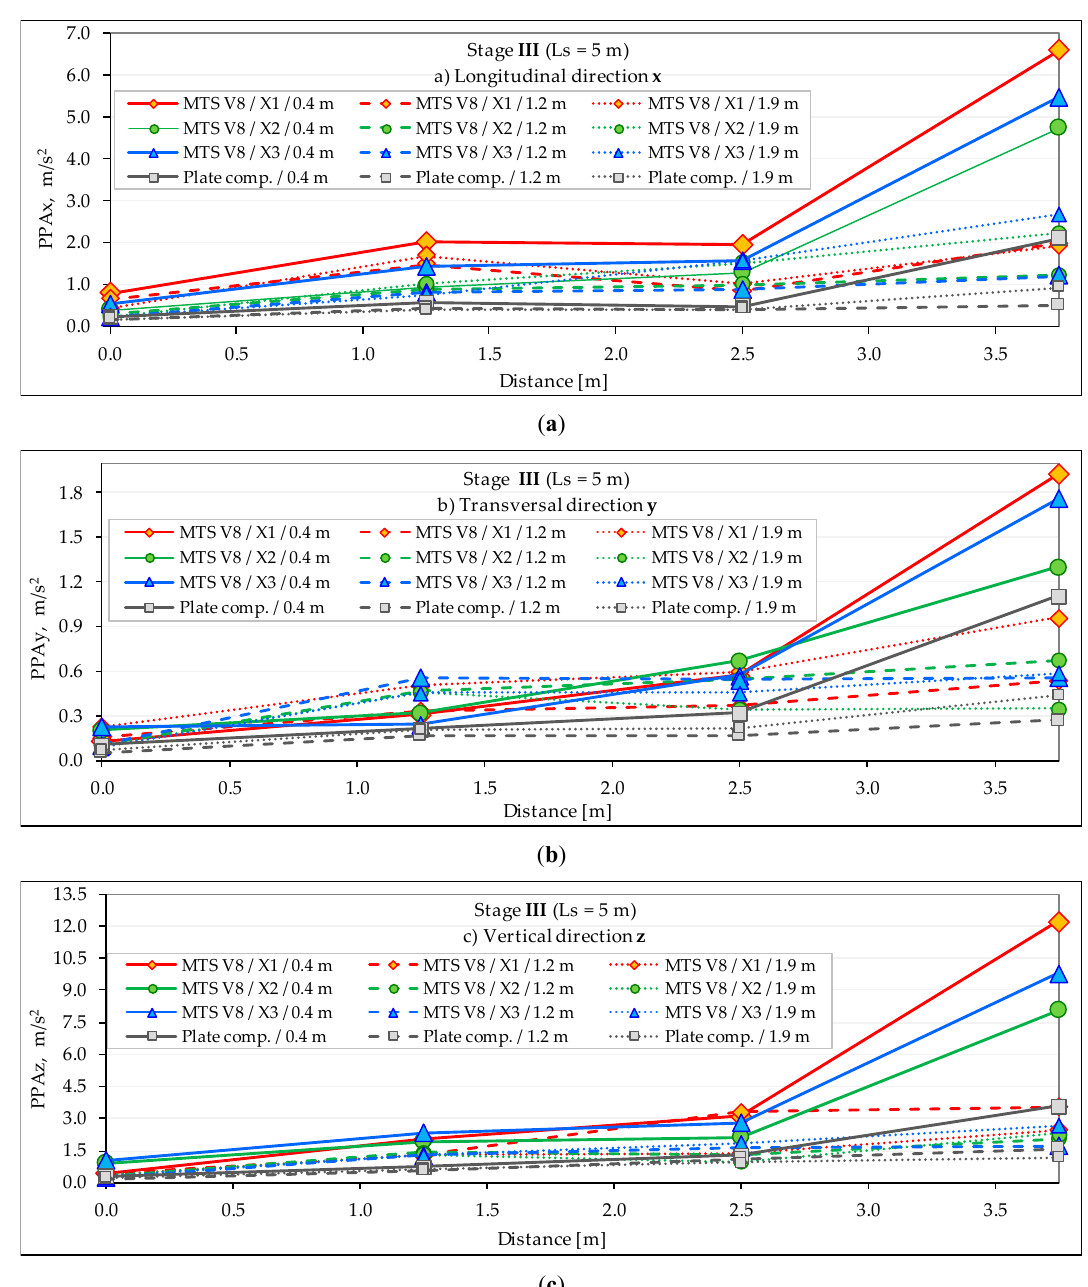
Figure 4. The PPAs—stage III (source of vibration at the distance of 5 m from the building) in directions: ( a ) –x; ( b ) –y; ( c ) –z.